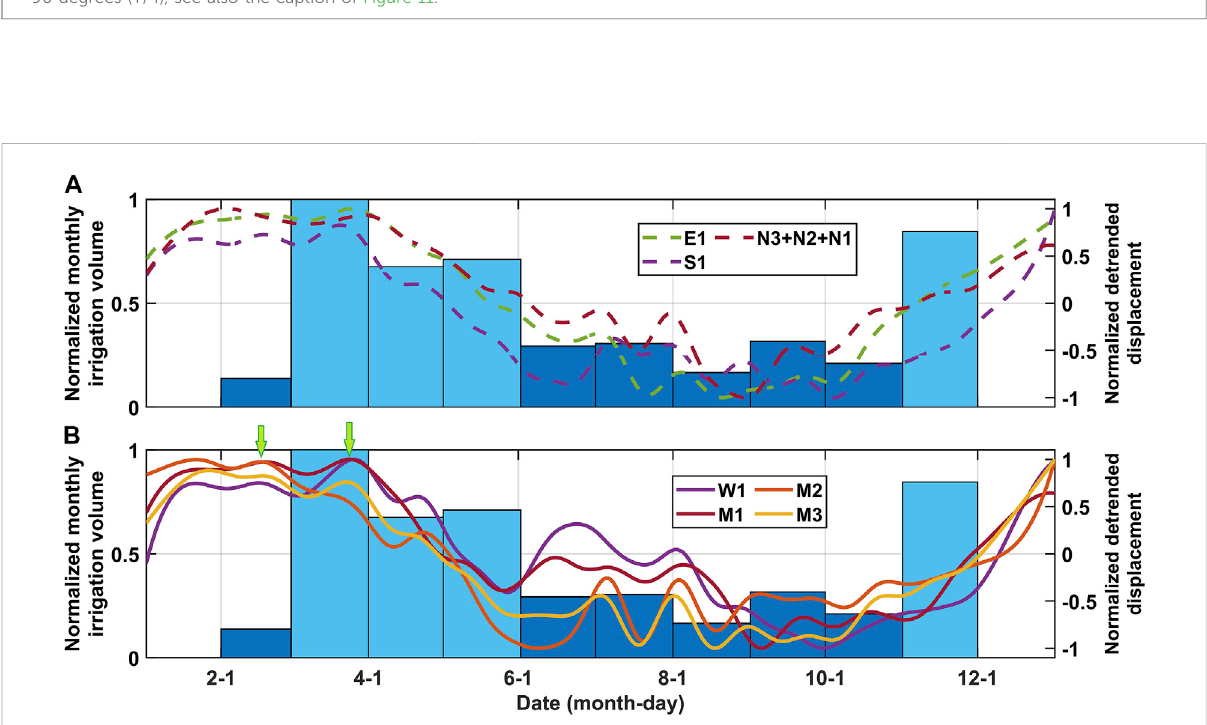
Annual allocation of crop irrigation (blue bars, left vertical axes) against detrended displacements (colored lines, right vertical axes). (A) Regions at the edge and (B) regions upon the platform shown in Figure 7. Light blue bars correspond to months with greater volume of irrigation in marked comparisonwiththeothersinmazarine.ItistobenotedthatnoirrigationinJanuaryandDecemberiscarriedout.BecausedisplacementsofN1,N2, and N3 close to each other are highly correlated, a substitute of sum from them is done. Green arrows in (B) highlight the time mismatch of onset between M2 and the